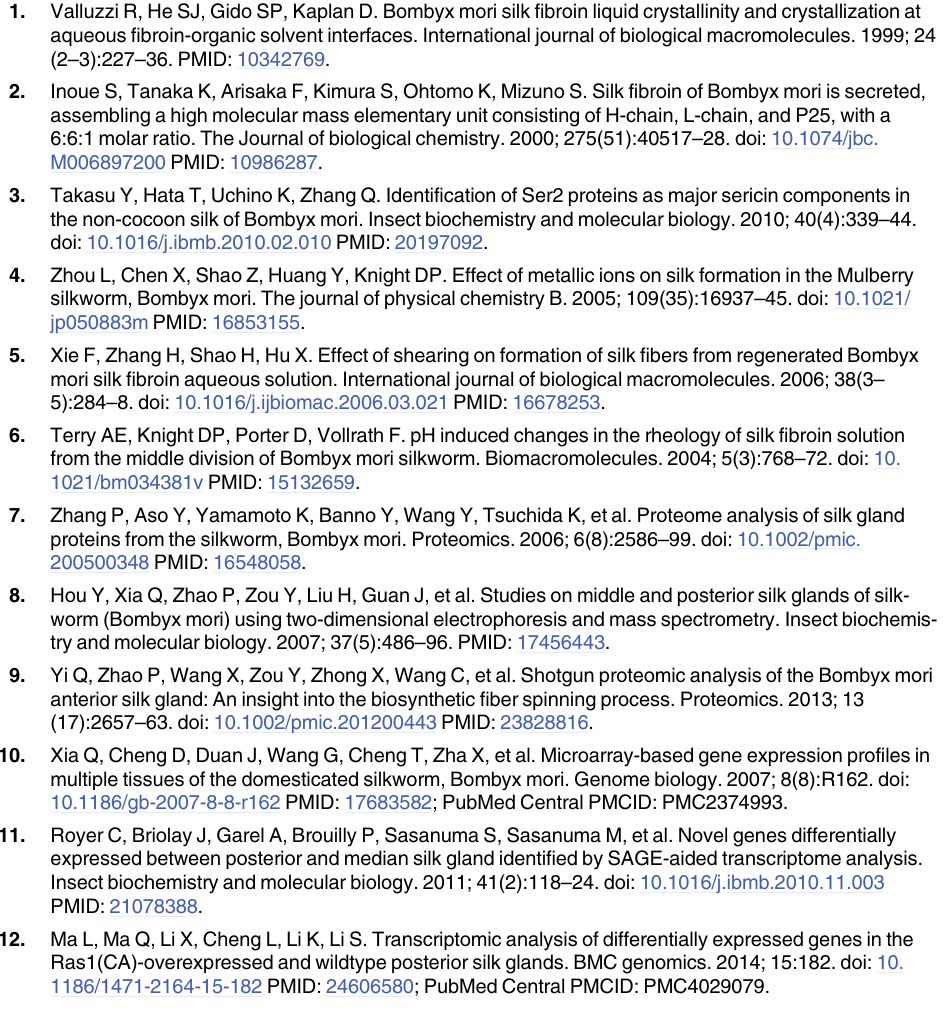
S9 Table. KEGG pathways of the up-regulated genes in the ASG. S10 Table. The genes encoding cuticular proteins expressed in the ASG. ‘ Y ’ indicates the gene was found in the related report, and ‘ N ’ indicates not found. S11 Table. Gene expression difference between the male and the